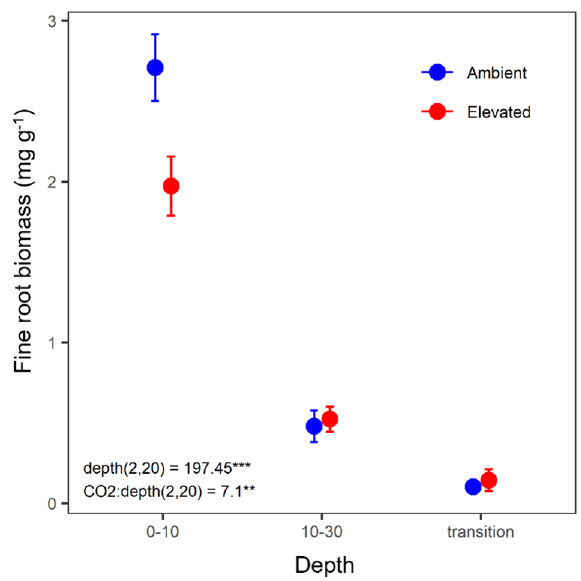
Figure 2. Biomass of fine roots of less than 3mm thickness (mgg − 1 ) in the mature Eucalyptus forest soil exposed to ambient (blue) and elevated (red) CO 2 for three depths (0–10 and 10–30cm and transition). Error bars indicate standard error. Mixed-effects model output stated the (degrees of freedom, Df, and Df residu- als) F statistic presented, and asterisks for the P values for signifi- cance are as indicated, where ∗∗∗ indicate P< 0 . 001, and ∗∗ indicate P< 0 .